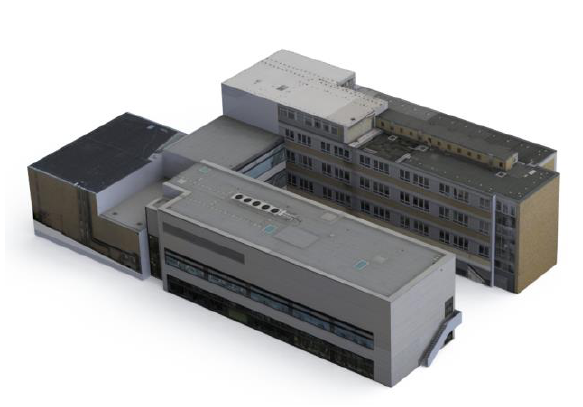
Figure 5. High resolution 3D building reconstruction